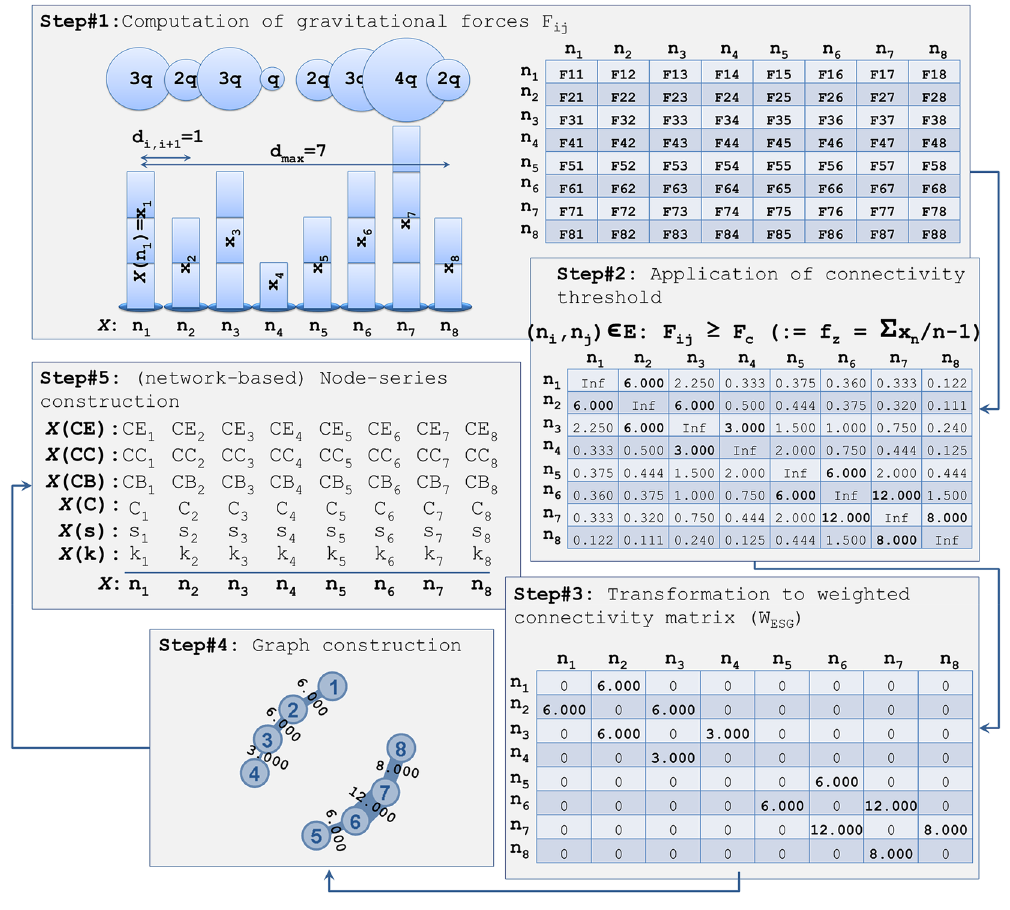
Figure 2. The methodological framework of the study. Steps #1–#4 describe the ESG algorithm generating an electrostatic graph from a time-series X = { x i | i = 1, …, 8}. Step#5 describes the process of generating secondary time-series from the network measures of ESG( X ).